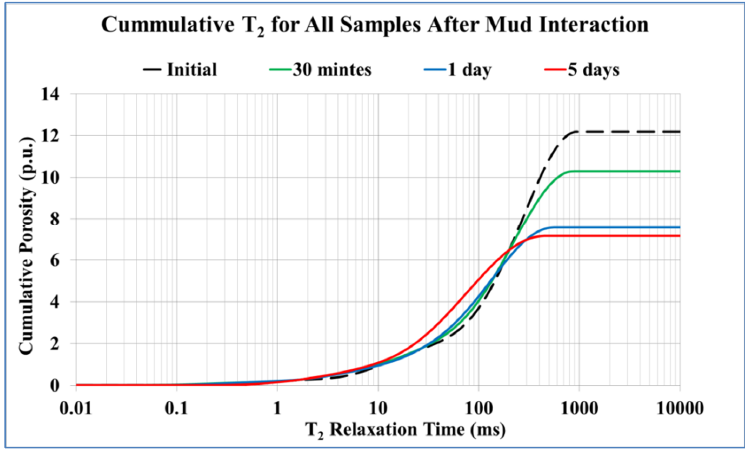
Figure 8. Cumulative T 2 for the core samples after the interaction with the drilling fluid.